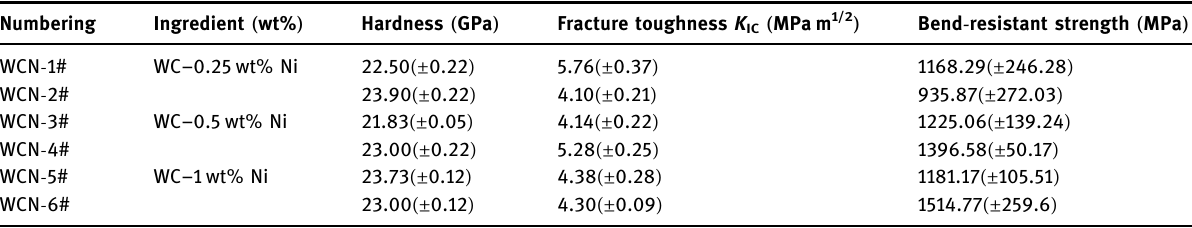
Table 3: Performance of WC – Ni composite